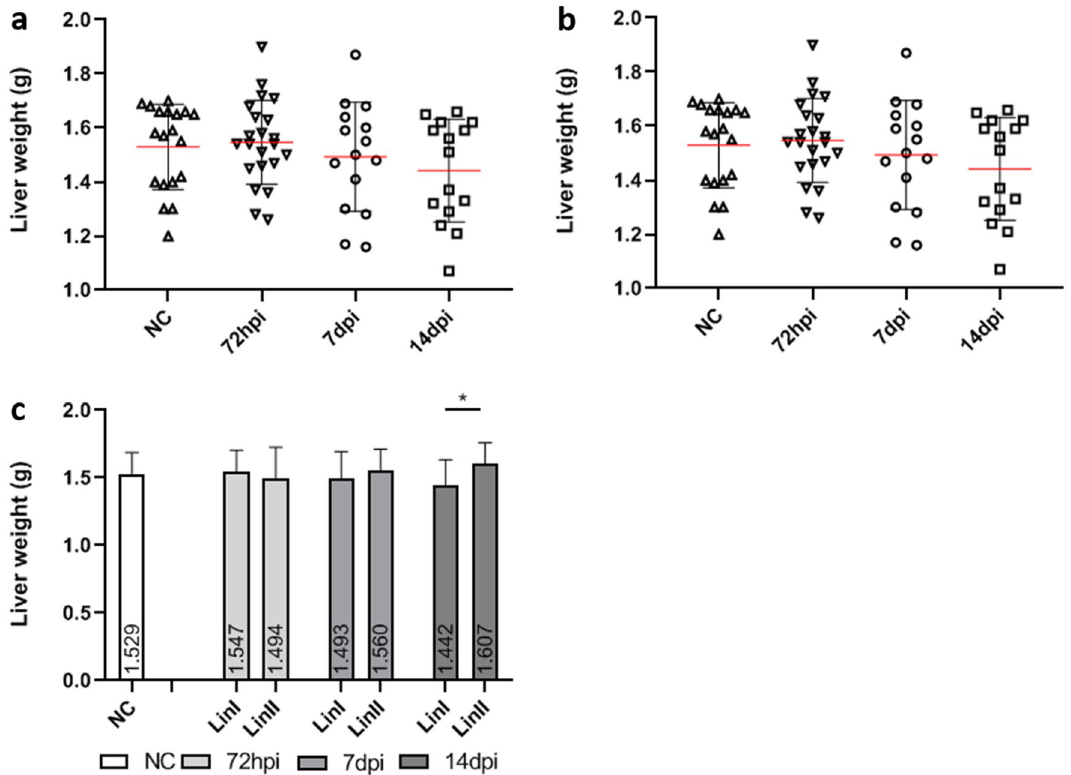
Figure 2. Liver weight of BALB/c mice uninfected and infected with DENV-2 Lineages 72 hpi, 7 and 14 dpi. ( a ) DENV-2 Lineage I; ( b ) DENV-2 Lineage II; ( c ) comparison of liver weight means. NC: (n = 19); Lin I: (n: 72 hpi = 22; 7dpi = 15; 14 dpi = 15); Lin II: (n: 72 hpi = 22; 7dpi = 15; 14 dpi = 15). n: number of mice, NC: negative control, Lin: Lineage, hpi: hours post-infection, dpi: days post-infection, * p < 0.05.